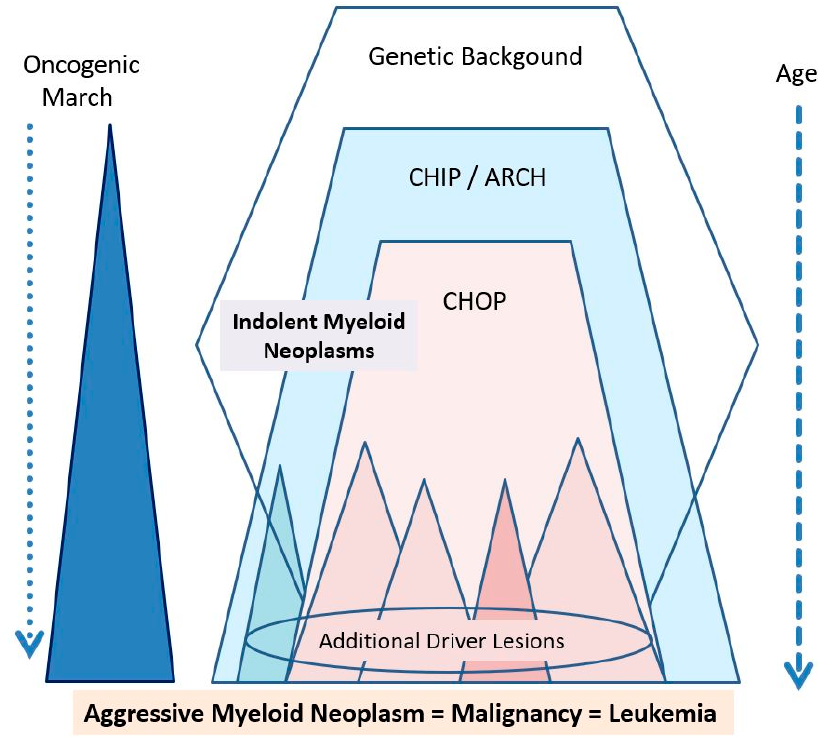
Figure 2. Major players contributing to the ‘oncogenic march’ in myeloid neoplasms. The genetic background may form the basis of a familiar predisposition to the development of hematopoietic